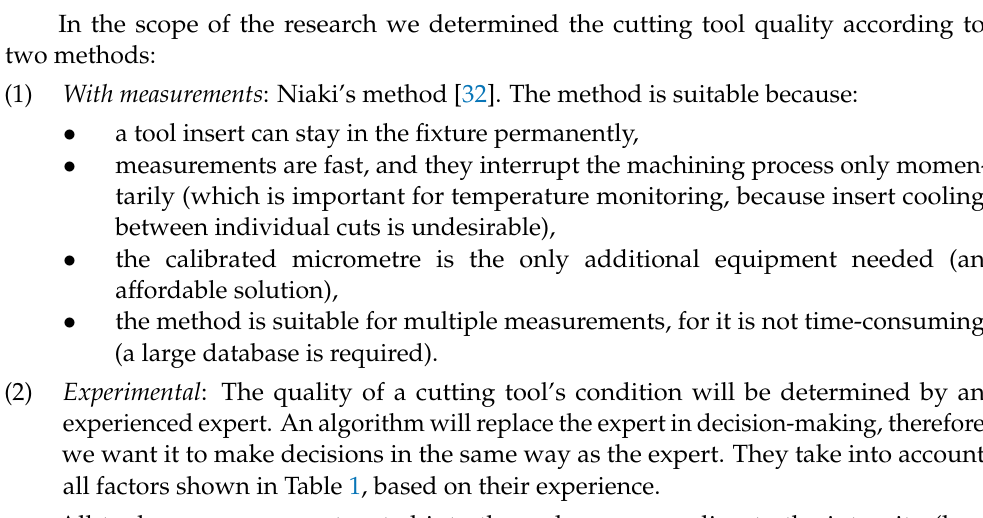
Figure 4. The effect of a cutting tool wear on the workpiece diameter deviation ( r 1 is actual workpiece radius, r 2 is expected workpiece radius in case of no tool wear).